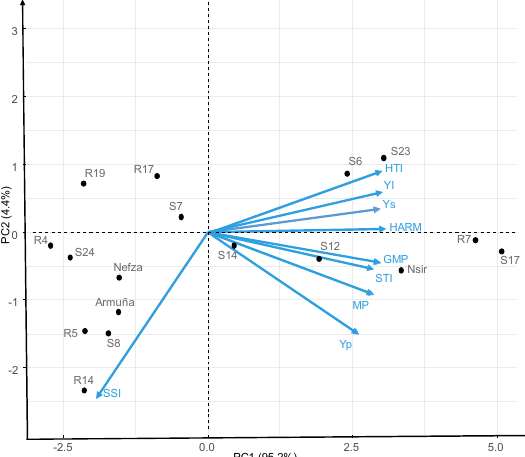
Figure 6. Biplot of principal component analysis of 17 lentil lines for productivity and stress indices.